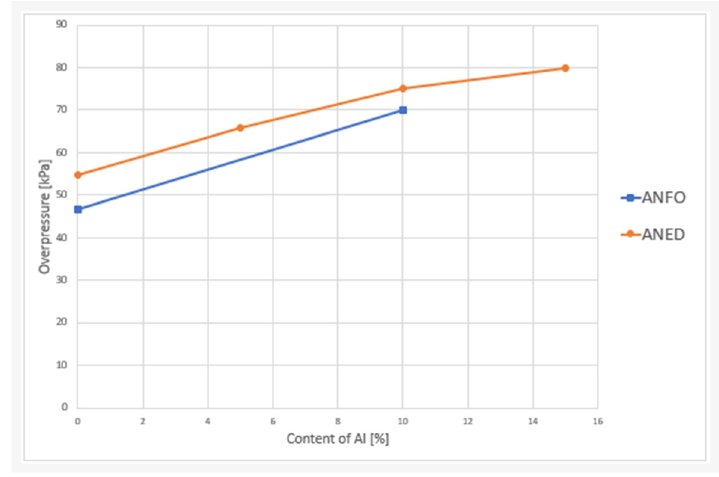
Figure 10. Dependences of blast wave overpressure on the aluminium content in AN/fuel mixtures with the addition of aluminium at a distance of 2 m from the load.